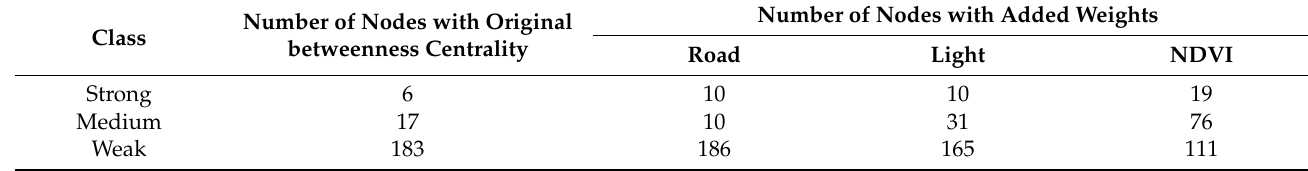
Table 4. Comparison of original and adjusted network results. Number of Nodes with Original Class betweenness Centrality